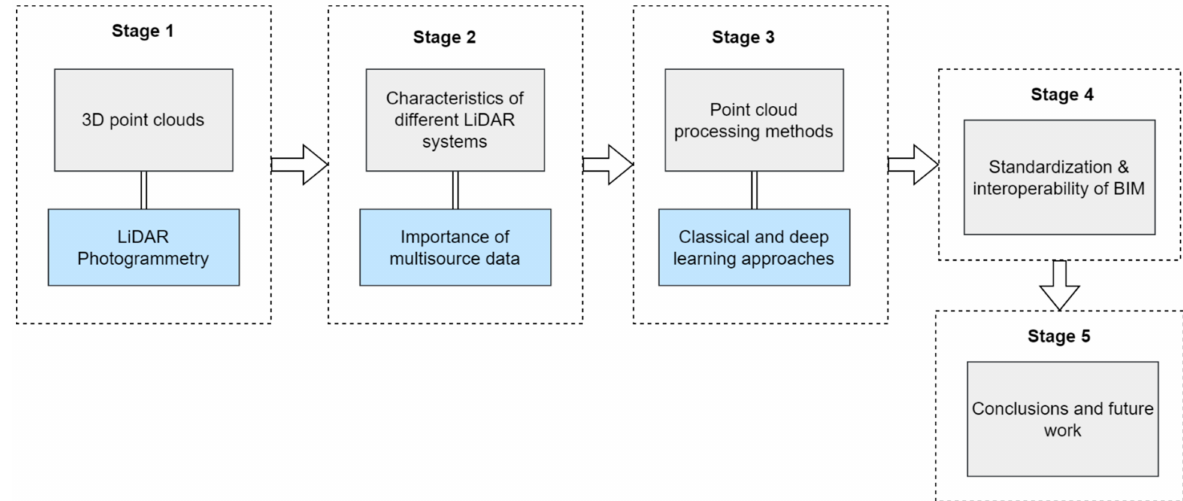
Figure 1. Overview of research methodology.